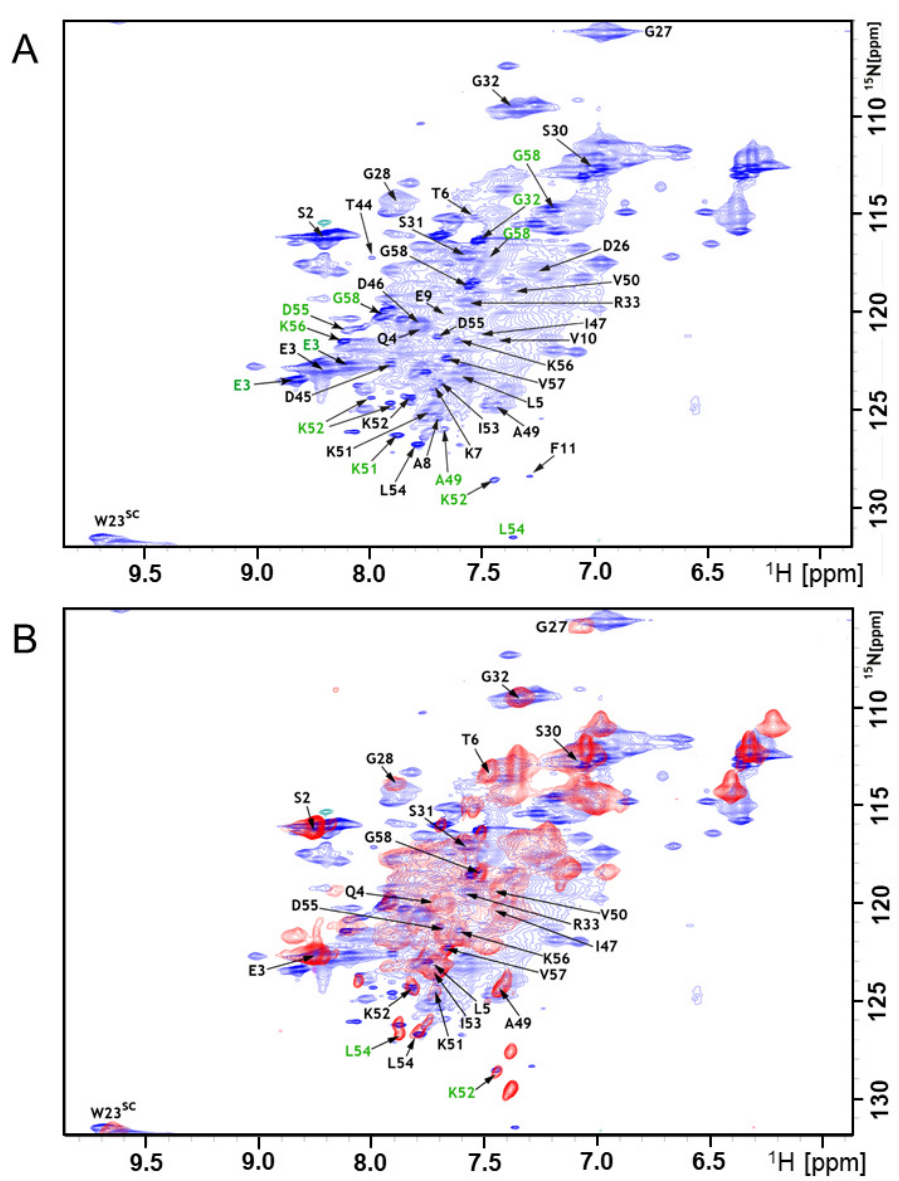
Figure 5. Backbone resonance assignment at pH 4.5 ( A ) 1 H- 15 N HSQC in the absence of bicelles with assignments indicated by residue number and arrows in black. Residues E3, G32, A49, K51, K52, L54, D55, K56, G58, highlighted in green, showed additional signals in the presence of bicelles. ( B ) Overlay of the 1 H- 15 N HSQC in the absence (blue) and presence of bicelles (red) with assignments indicated by residue number and arrows in black. Residues K52 and L54, highlighted in green, showed minor additional signals as indicated.